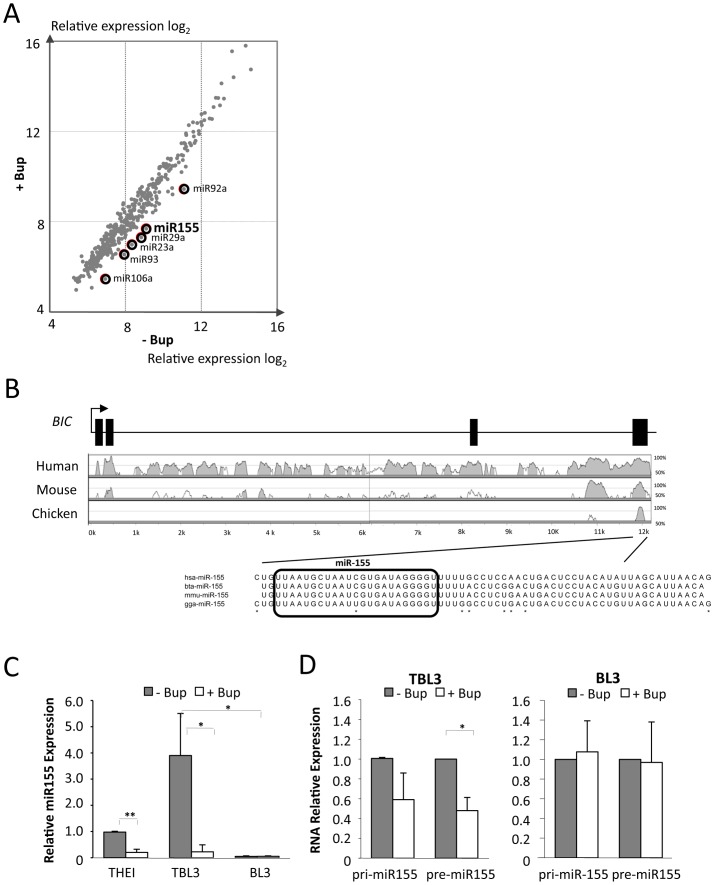
The oncomiR miR-155 is upregulated in cells transformed by Theileria.
(A) We performed miRNA microarray analysis using RNA from parasitized TBL3 cells, treated or not with Buparvaquone for 64 hours. The scatter blot represents the expression of all 459 miRNA data points. Six miRs (highlighted by circles) were down-regulated by more that 2.5-fold (log2) upon Buparvaquone treatment. (B) The Vista plot shows conservation of the BIC gene, comparing bovine to human, mouse or chicken sequences. The miR-155 sequence is identical in the bovine (Bta), human (Hsa) and chicken (Gga) genomes. The square boxes represent the positions of the exons in the human BIC gene. Black arrow represents the Transcriptional start site (TSS). (C) Analysis of miR-155 expression by TaqMan qPCR comparing RNA isolated from Thei, TBL3 or BL3 cells in the presence or absence of Buparvaquone (Bup). Transcript levels in untreated cells are shown relative to the control and normalized against RNU6B mRNA (average ± sd, n = 3). (D) Relative RNA levels of immature pri-miR-155 or pre-miR-155 transcripts in parasitized TBL3 or parental BL3 cells in the presence or absence of Buparvaquone (Bup). Transcript levels in untreated cells are shown relative to the control and normalized against β-actin and B2M mRNA (average ± sd, n = 3). *p<0.05, **p<0.01, ***p<0.001.